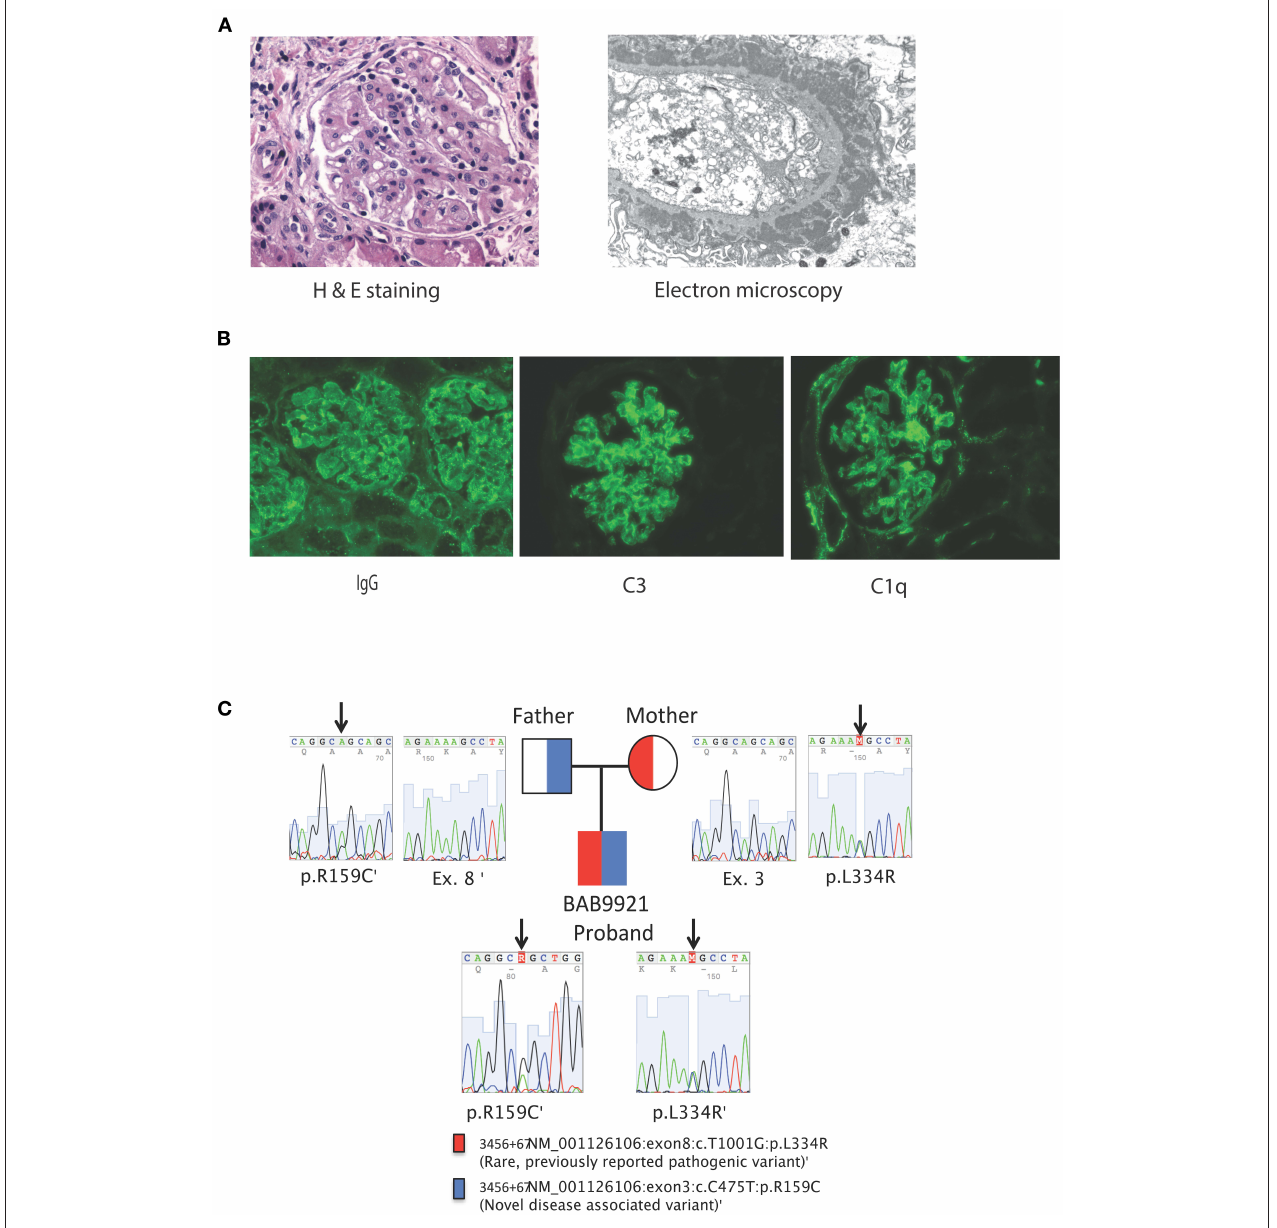
FIGURE 1 | (A) From left to right, Kidney biopsy hematoxylin and eosin stain, original magnification x 400. The glomerulus shows a lobular architecture and capillary loops with increased thickness and double contours. There is endocapillary and mesangial proliferation with mononuclear cells. On the left, an arteriole shows moderate sclerosis. Kidney biopsy electron microscopy, uranyl acetate-lead citrate stain, original magnification x 6000. The glomerular capillary loop shows massive, confluent, subepithelial electron-dense deposits with spike formation from the basement membrane mimicking stage II of a membranous pattern of injury. There are several scattered, small electron-dense deposits in subendothelial areas. The endothelium is very swollen and contains multiple tubulo-reticular inclusions. (B) Kidney biopsy immunofluorescence with antibodies against IgG, C3 and C1q original magnification x 200. Both glomeruli show coarse and fine granular deposits in the mesangium and peripheral capillary loops. There are also some granular deposits at the tubular basement membranes. Immunofluorescence studies were also positive for C3 and C1q granular deposits, mainly at the mesangium, but also present on segments in a subendothelial location. (C) Family pedigree and Sanger tracings of patient SLC7A7